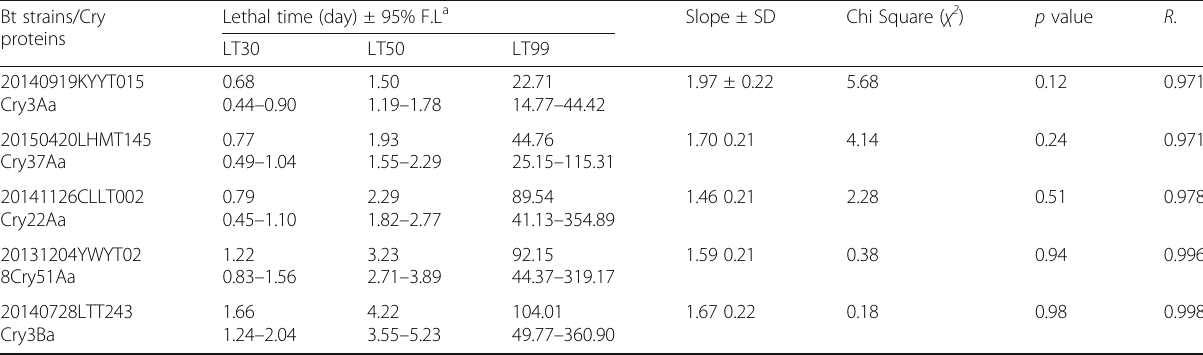
Table 3 Lethal and sublethal times of various Cry proteins after treatment of third instar larvae of Tribolium castaneum at the highest concentration (2 g/10 g) Bt strains/Cry proteins